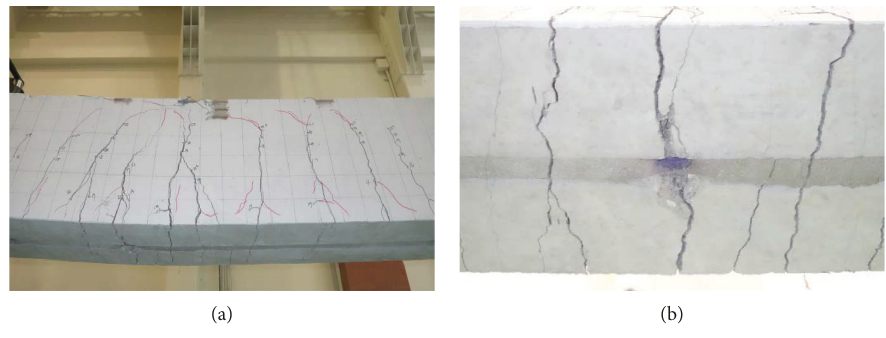
Figure 16: Tensile failure of strengthened